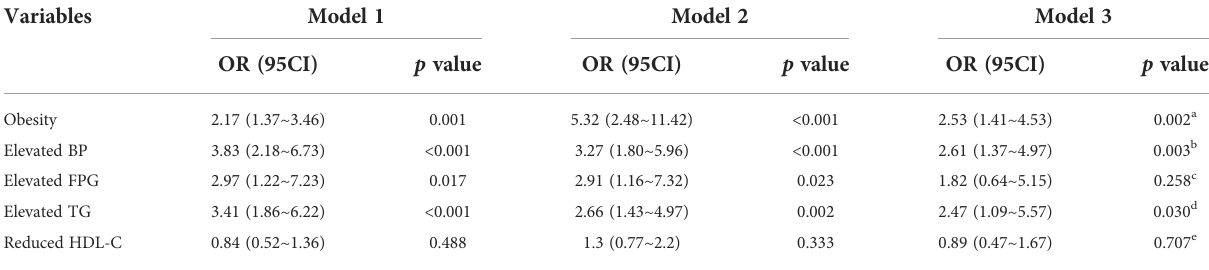
TABLE 4 Multivariable logistic regression analysis of the association between hyperuricemia and metabolic syndrome components.